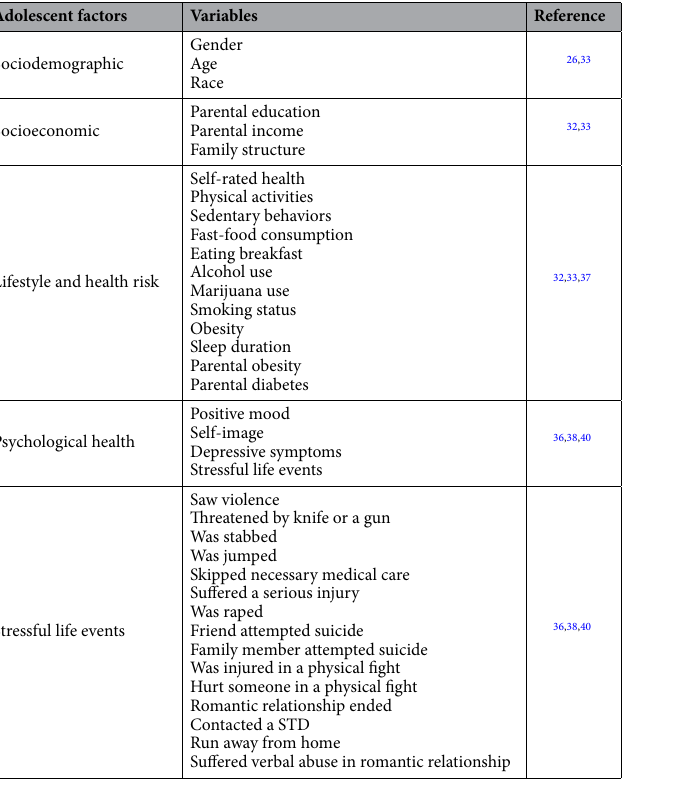
Table 1. Predictors selected for long-term CVD risk